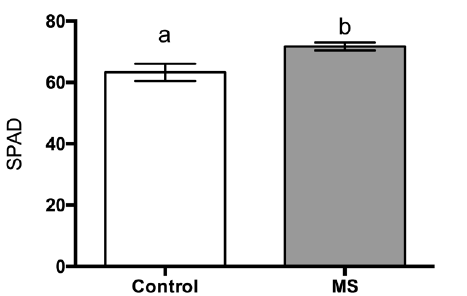
Figure 3: Stem diameter at the first and sixth node for control and mechanically stimulated pepper plants. Bars within each grouping (e.g., first node) with the same letter do not differ at p≤0.05. Error bars are